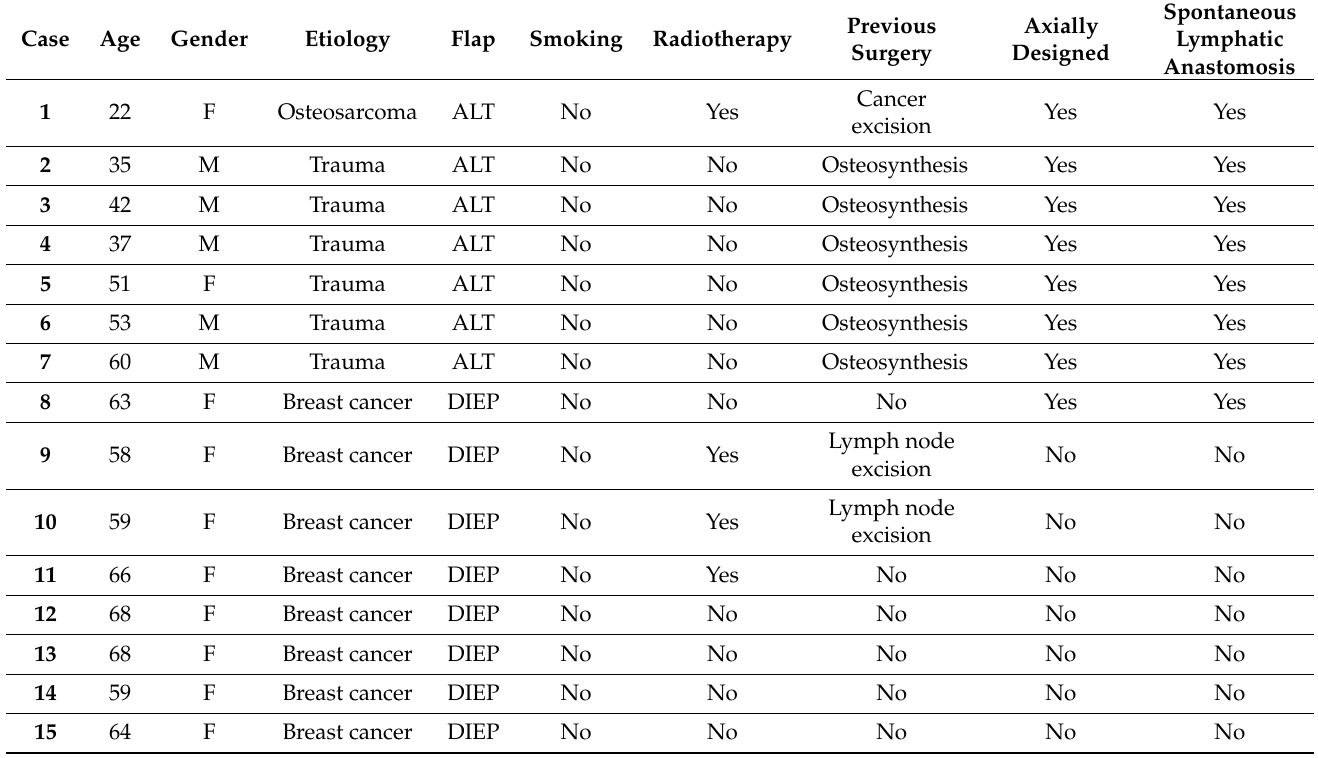
Table 1. Patients characteristics .